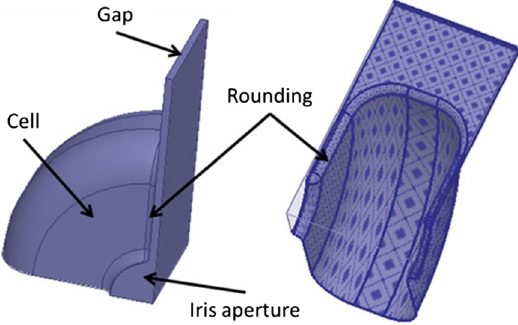
[9].FIG. 2. HFSS model of a single cell quarter, a flatbed region representing gap added to house the metal joining surface